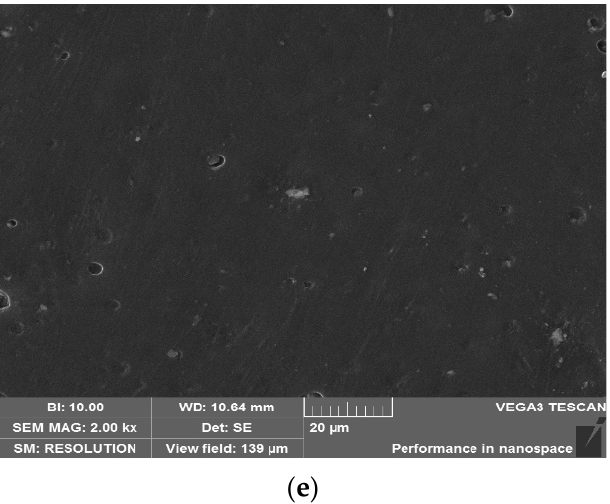
Figure 1. Surface micromorphologies of ( a ) 1#, ( b ) 2#, ( c ) 3#, and ( d ) 4# under a magnification of 50.00 k× and that of ( e ) 0# under a magnification of 2.00 k× .